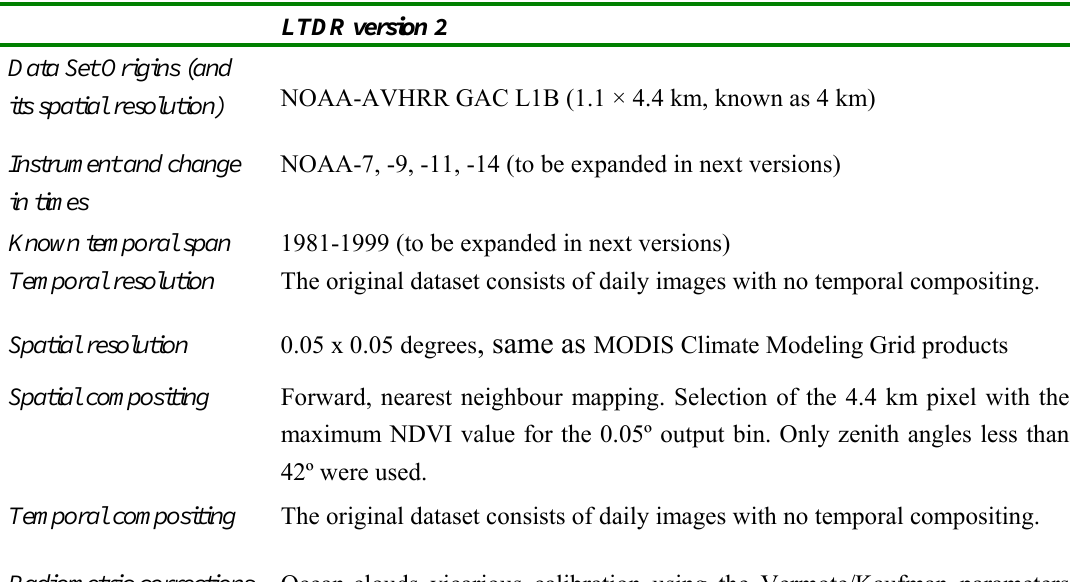
Table 1. Description of the AVHRR LTDR NDVI dataset [2,28] used in this study (this table extends the comparison across PAL-II, FASIR, and GIMMS provided by Table 1 in Baldi et al .